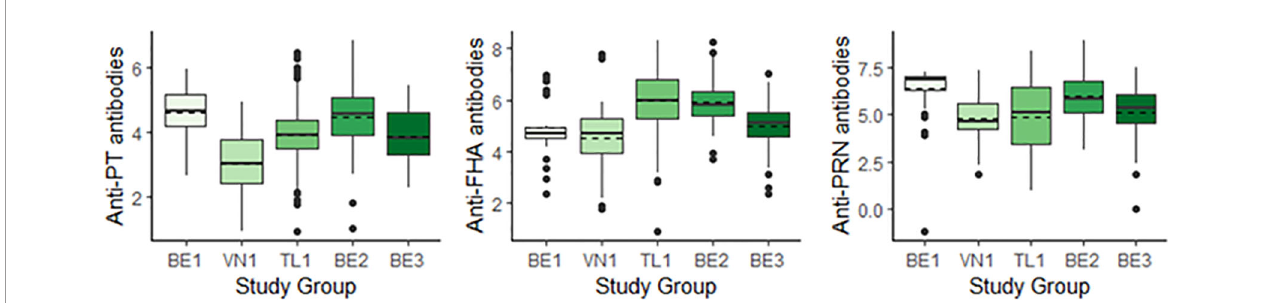
FIGURE 1 | Boxplots comparing cord blood antibody titers across study groups for anti-PT (left), anti-FHA (centre) and anti-PRN antibodies (right), reported in IU/mL (BE1, VN1, TL1) or EU/mL (BE2, BE3). Geometric Mean Concentrations (GMCs) are represented by dashed horizontal lines. BE1, Belgium 1; VN1, Vietnam 1; TL1, Thailand 1; BE2, Belgium 2; BE3, Belgium 3; PT, Pertussis Toxin; FHA, Filamentous Hemagglutinin;